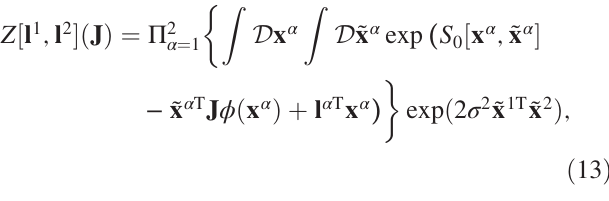
ffiffiffiffiffiffiffiffiffiffiffiffiffi p 1 − E